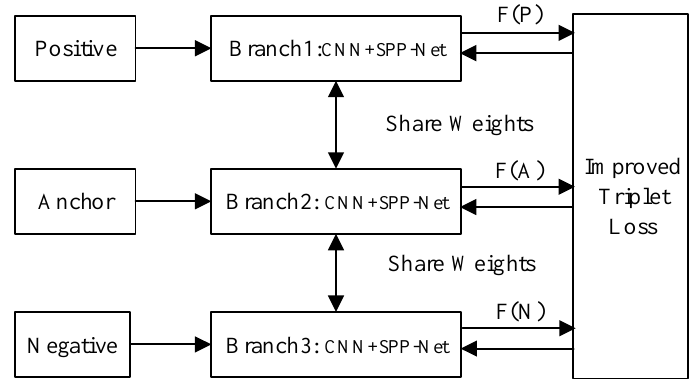
Figure 5. The construct of the triplet spatial pyramid pooling network.